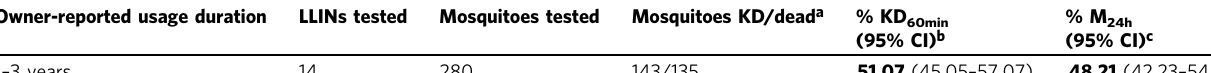
Table 2 Summary of the number of LLINs and number of mosquitoes tested according to owner-reported usage duration. Owner-reported usage duration